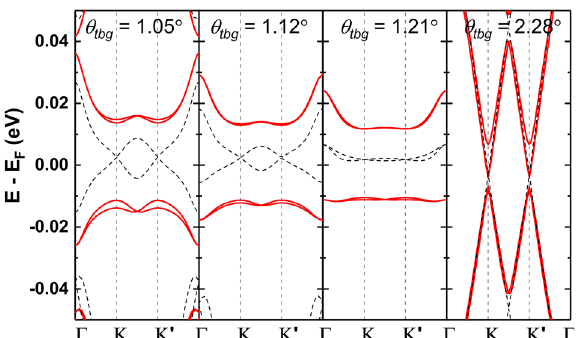
Fig. 2 Layer degeneracy breaking. Band structure (red solid lines) of TBG/hBN with θ bot = 0.53° and varying θ tbg . Black dashed lines are the band structures of the corresponding free-standing TBG at each θ tbg